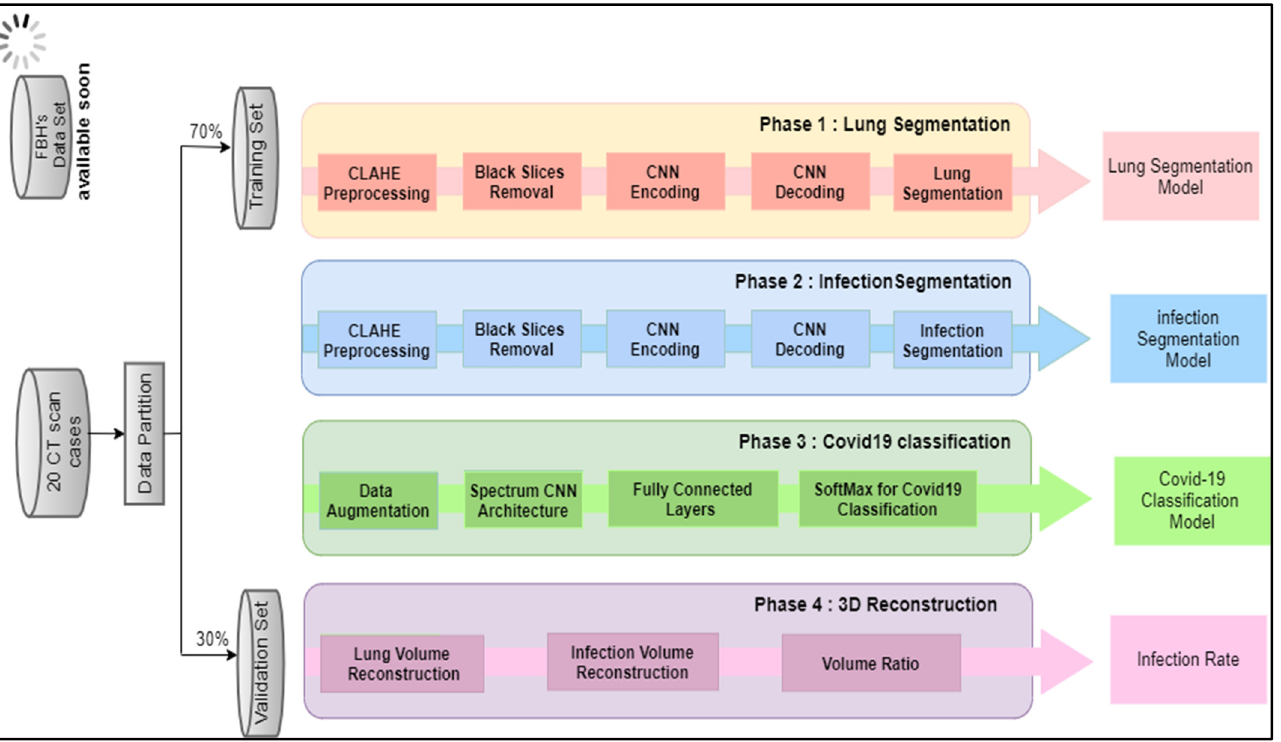
Figure 2. Flowchart of the different phases involved in the proposed diagnosis system.